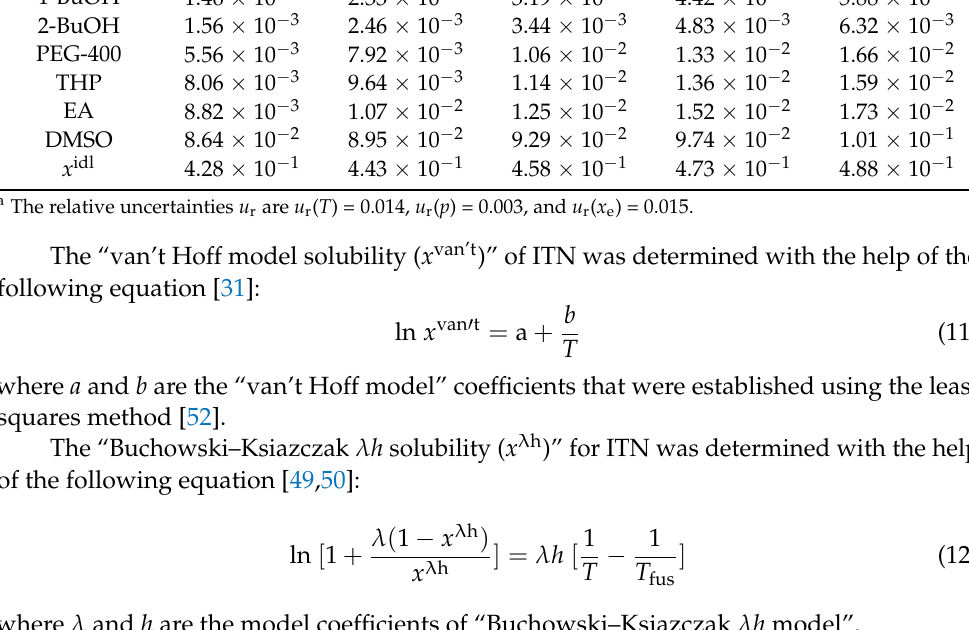
Table 1. Measured solubility ( x e ) and ideal solubility ( x idl ) data of isotretinoin (ITN) in mole fraction in eleven different green solvents (GS) at 298.2–318.2 K and 101.1 kPa a . GS T = 298.2